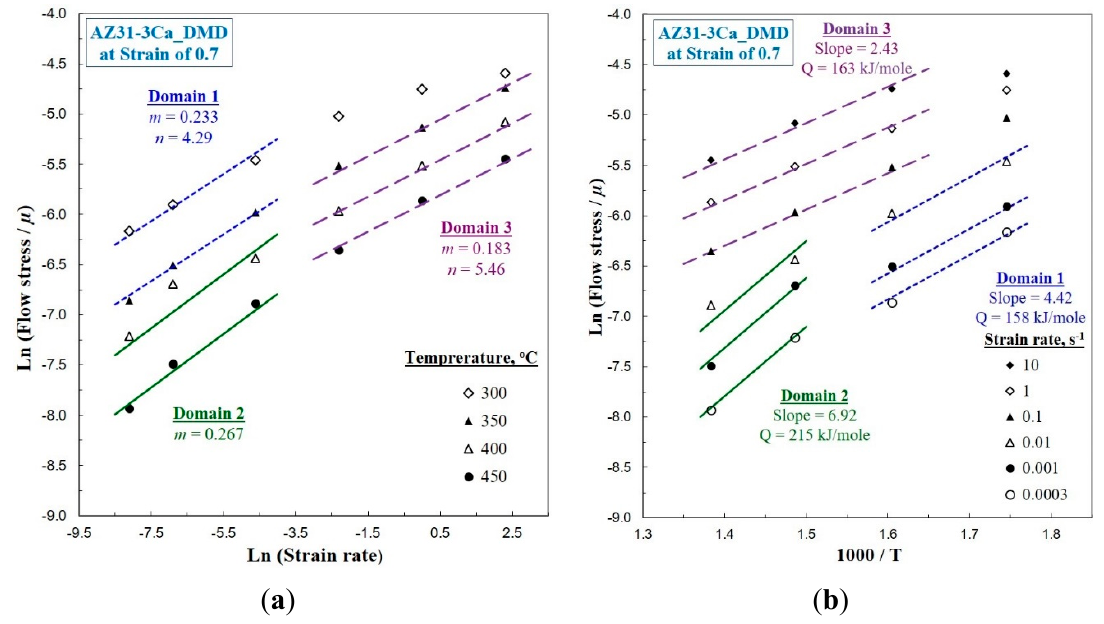
Figure 8. ( a ) Variation of normalized flow stress with strain rate on natural logarithmic scale, and ( b ) Arrhenius plot showing variation of normalized flow stress with inverse of absolute temperature for DMD processed AZ31-3Ca alloy.